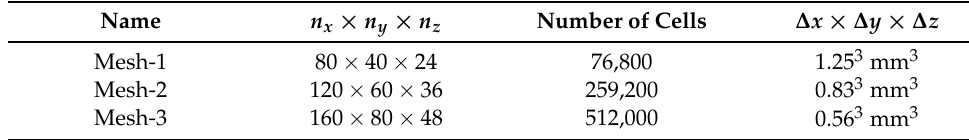
Table 1. Summary of the mesh parameters